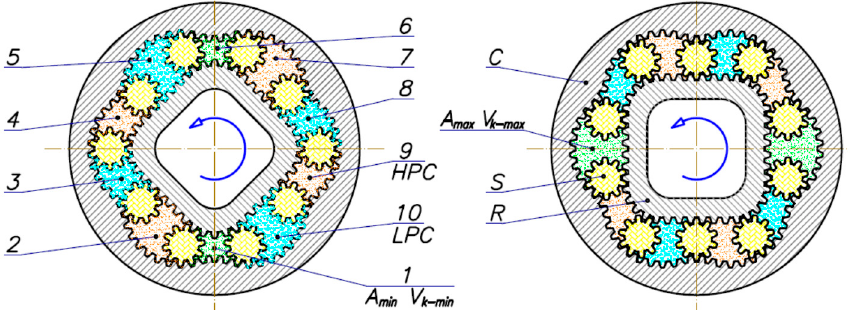
Figure 7. Satellite mechanism of type II [16,19–21]: C —curvature, R —rotor, S —satellite, 1–10—working chambers, HPC —high pressure chambers, LPC —low pressure chambers, V k-min —working chamber with minimum volume (dead chamber) and with minimum area A min , V k-max —working chamber with maximum volume and with maximum area A max .